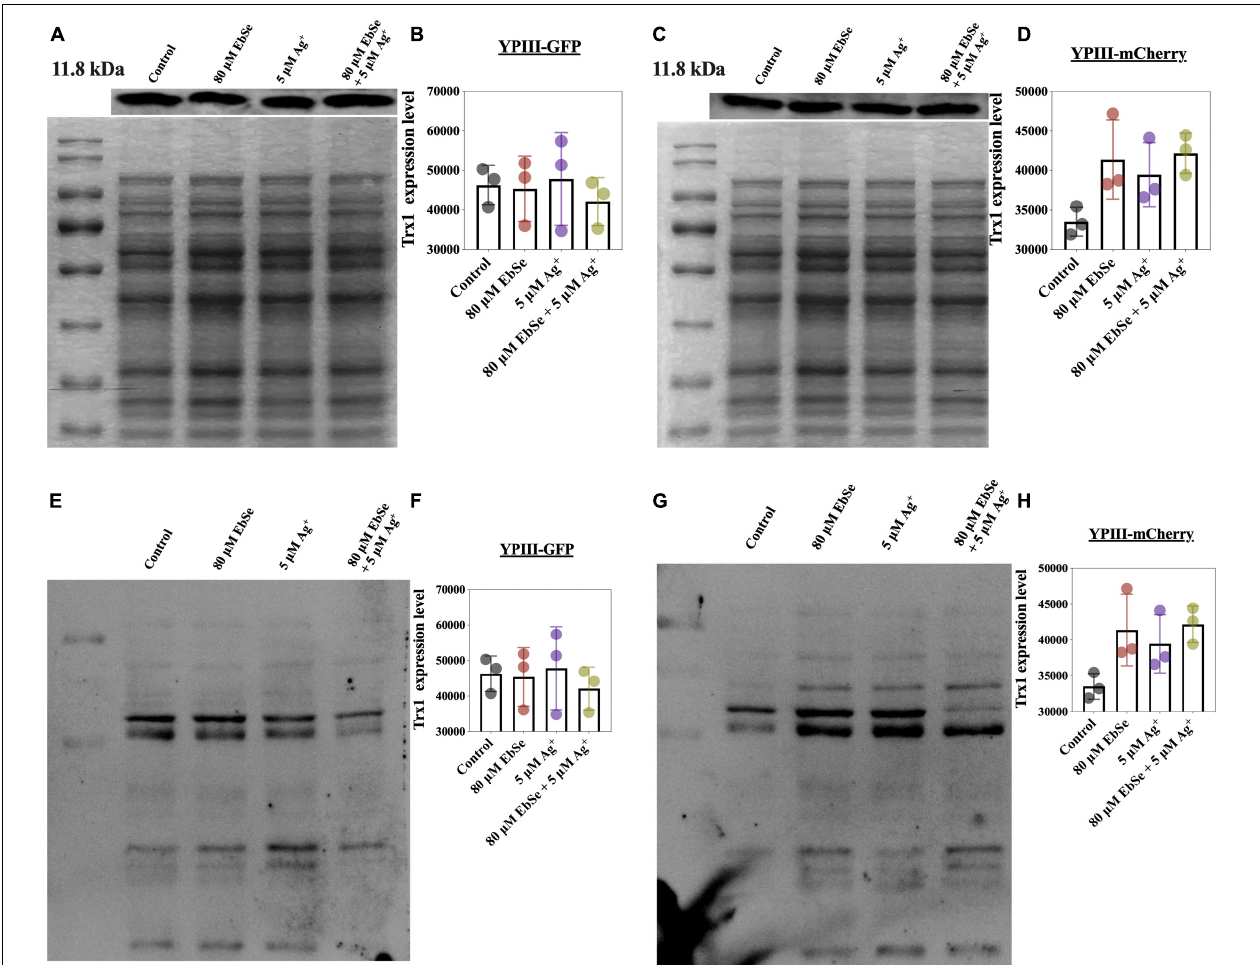
FIGURE 8 | Effect of EbSe-Ag + on Trx1 and S -PSSG expressions in YpIII. YpIII-GPF and YpIII-mCherry were cultured to A 600 of 0.4 and treated with EbSe-Ag + . WB assay was used to detect (A,C) the Trx1 expression level and (E,G) S -PSSG expression level; (B,D) quantitative values of the Trx1 expression level; (F,H) quantitative values of the S -PSSG expression level; (A,B,E,F) YpIII-GFP; (C,D,G,H) YpIII-mCherry.